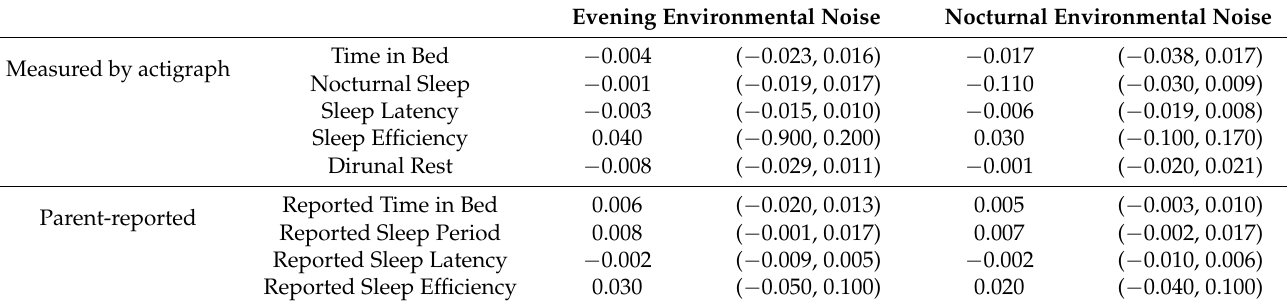
Figure 3. Scatter plots of sleep variables measured by actigraph and by questionnaires. Actigraphic measurements are shown on the x-axis, whereas the y-axis represents subjective measurements. Density plots for each variable and correlation estimates are also shown, with no significant correlations being observed. Table 4. Direct effects of evening and nocturnal environmental noise on sleep habits. Non- standardised B-estimates and 95% confidence intervals (in parenthesis) are